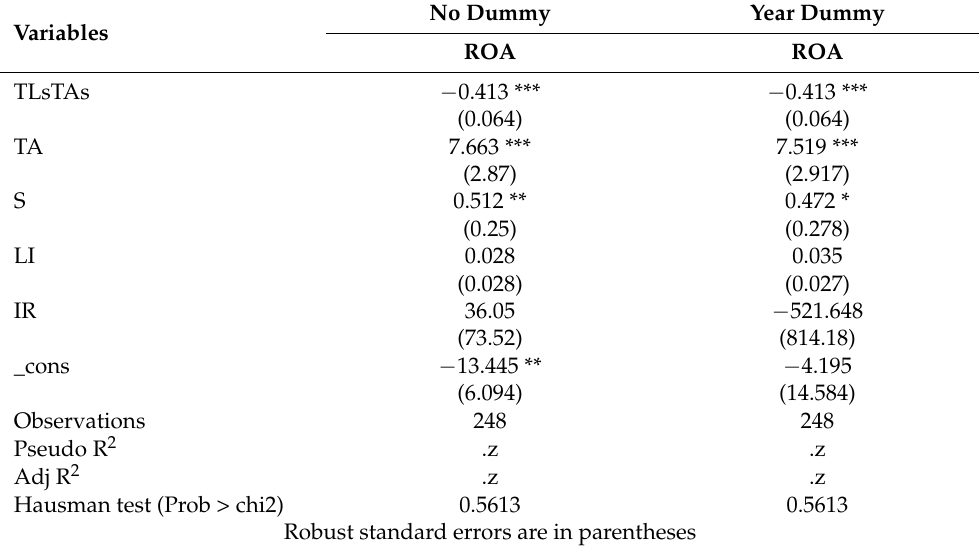
Table 14. Results of the Random Effects of TLsTAs on ROA, as per Panel Data Regression (Loss- Making